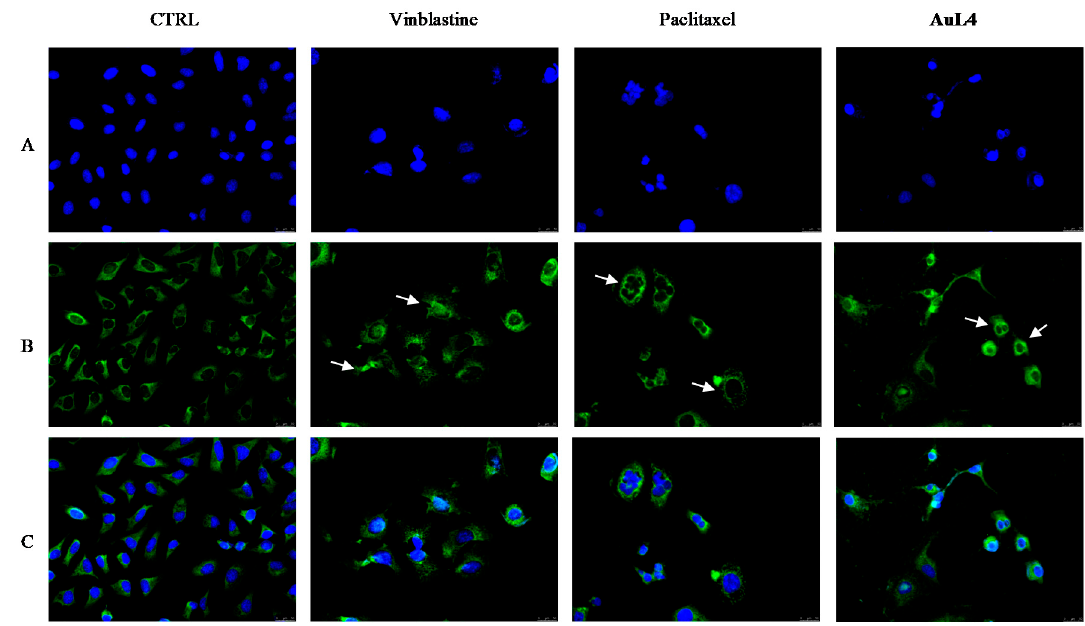
Figure 6. Immunofluorescence studies. HeLa cells were treated with AuL4 , Vinblastine, Paclitaxel (used at their IC 50 values) or with a vehicle (CTRL) for 24 h. After treatment, the cells were methanol fixed, incubated with primary and secondary antibodies, stained with DAPI and observed and imaged under the inverted fluorescence microscope at 20 × magnification (see Materials and methods). Vehicle-treated cells (CTRL) exhibited a normal arrangement and organization of the cytoskeleton. Microtubules of HeLa cells treated with vinblastine and paclitaxel showed an irregular arrangement and organization: particularly, tubulin crystal formation (white arrows, panel B , vinblastine) and tubulin bundles and thicken fibers (white arrows, panel B, paclitaxel) can be noted for vinblastine and paclitaxel respectively. Treatment with AuL4 shows a paclitaxel-like mode of action (white arrows, panels B, AuL4 ). Panels A : DAPI, excitation / emission wavelength 350 nm / 460 nm; panels B : β -tubulin (Alexa Fluor ® 488) excitation / emission wavelength 490 nm / 515 nm; panels C show a merge. Representative fields are shown.